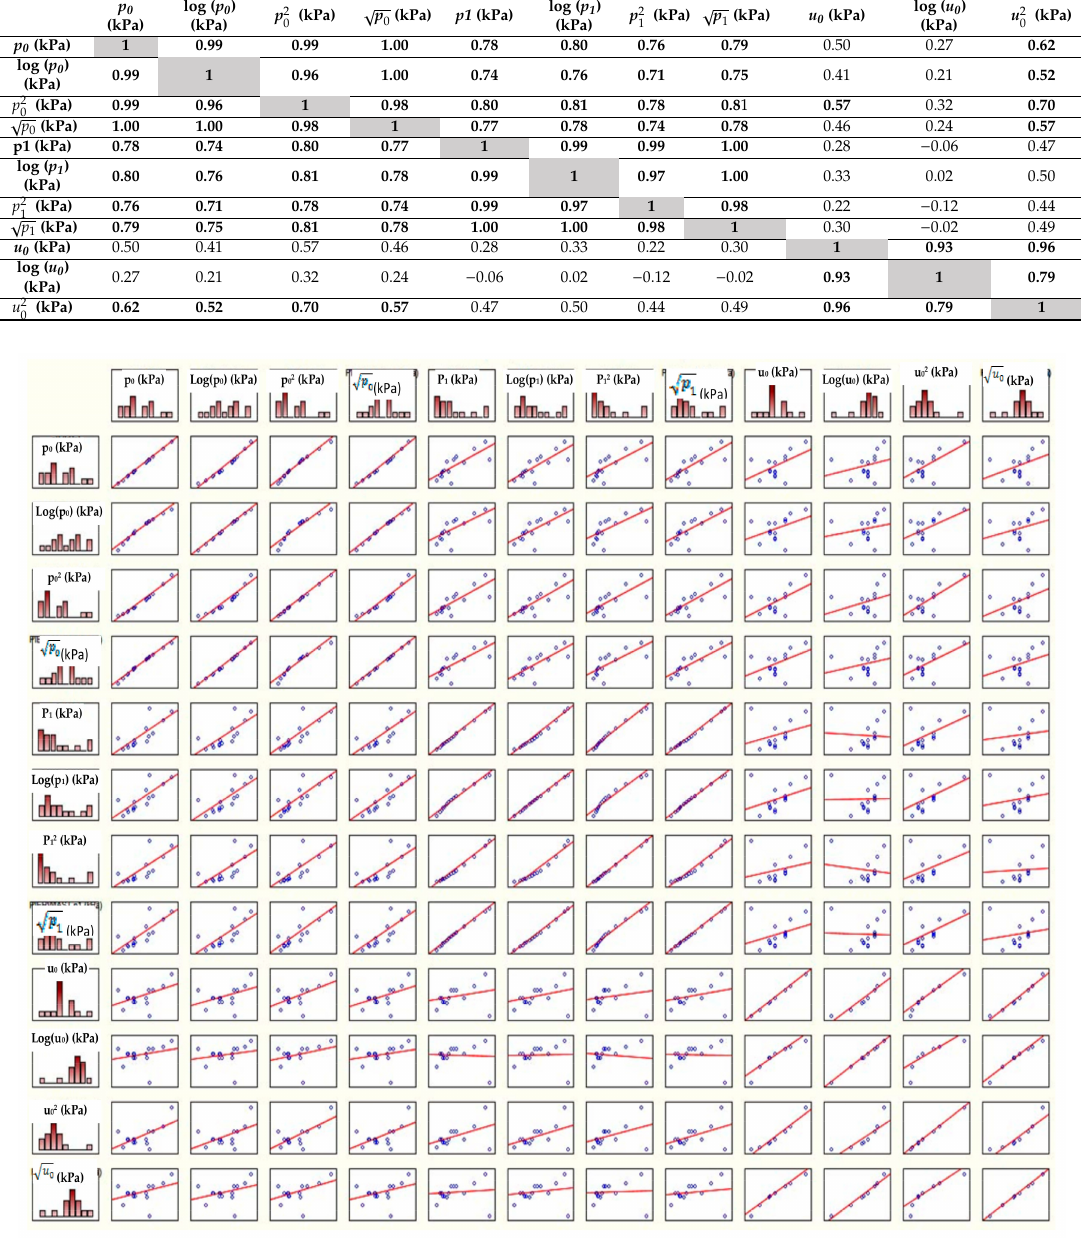
Figure 5. Matrix of extended charts for selected variables (dilatometer